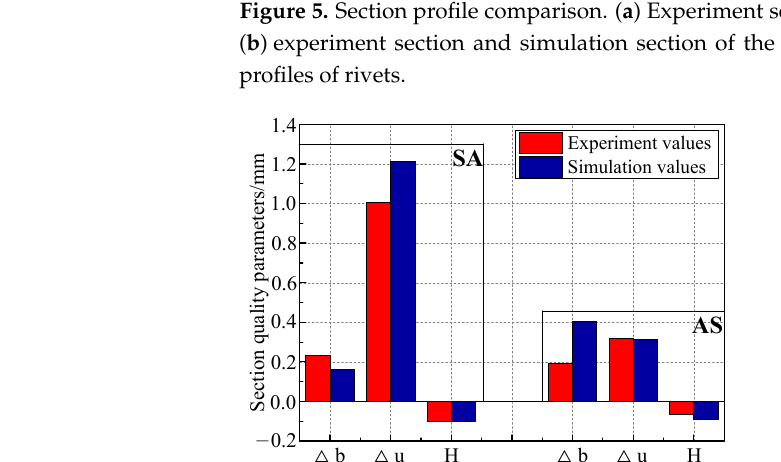
Figure 6. Forming parameters of the two joints.